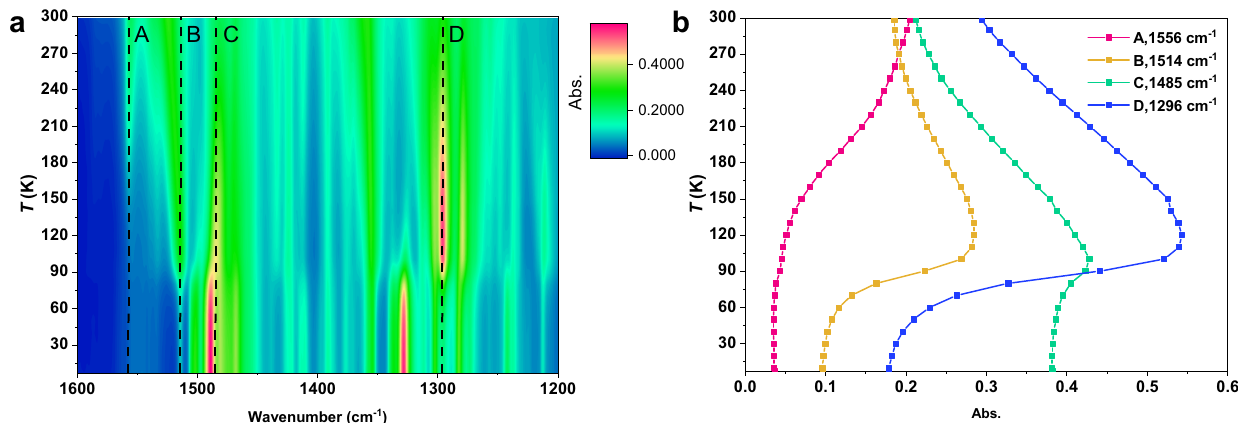
Fig. 4 Variable-temperature IR spectroscopy of the [FeCo] crystals. a 2D color map of the variable-temperature IR absorption spectra for the range of 1200 – 1600cm − 1 for the temperature range of 300 – 10K. Dashed lines represent the characteristic absorption bands. Abrupt change in absorbance at 1514cm − 1 (line B) and 1296cm − 1 (line D) is observed at approximately 90K (Supplementary Fig. 8), which is consistent with the spin transition temperature. Even above spin transition temperature, a gradual change in absorbance is clearly detected. Absorbance at 1556cm − 1 (line A) and 1485cm − 1 (line C) gradually increases and decreases with increasing temperature, respectively. Absorbance at 1556cm − 1 and 1485cm − 1 is assignable to that of dhbq 2 − and dhbq 3 − , respectively, suggesting that the increase of the population of C [Fe 2 + HS – dhbq 2 − – Co 3 + LS ] state on the increment of temperature. b Temperature-dependent IR absorptions of selected wavenumbers shown in panel a